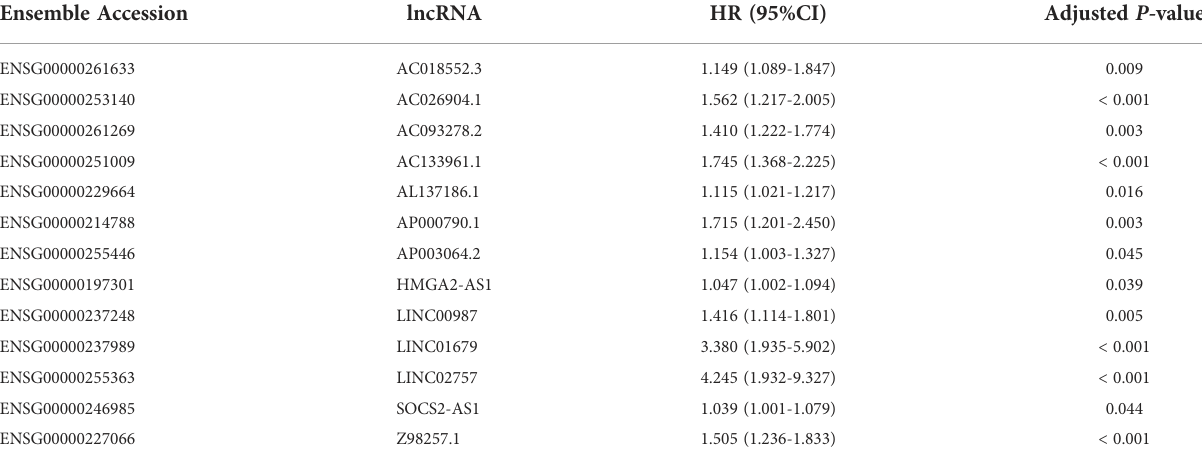
TABLE 1 Univariate Cox regression of 13 lncRNAs for the OS of AML patients. Ensemble